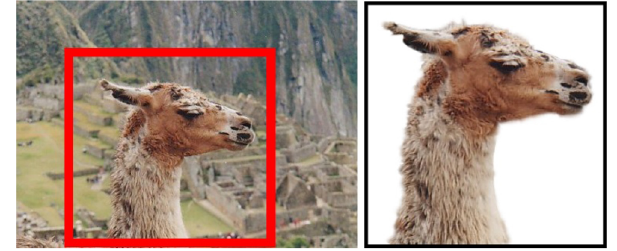
Fig. 3 Interactive figure–ground segmentation using GrabCut [18].